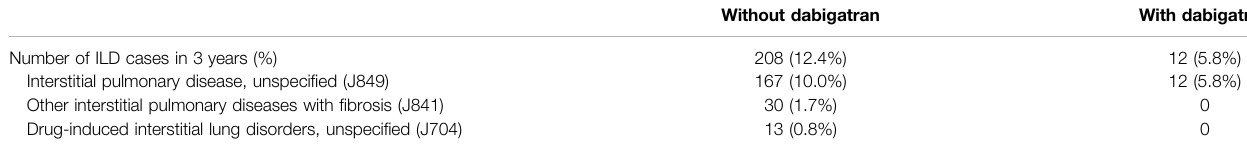
Without dabigatran